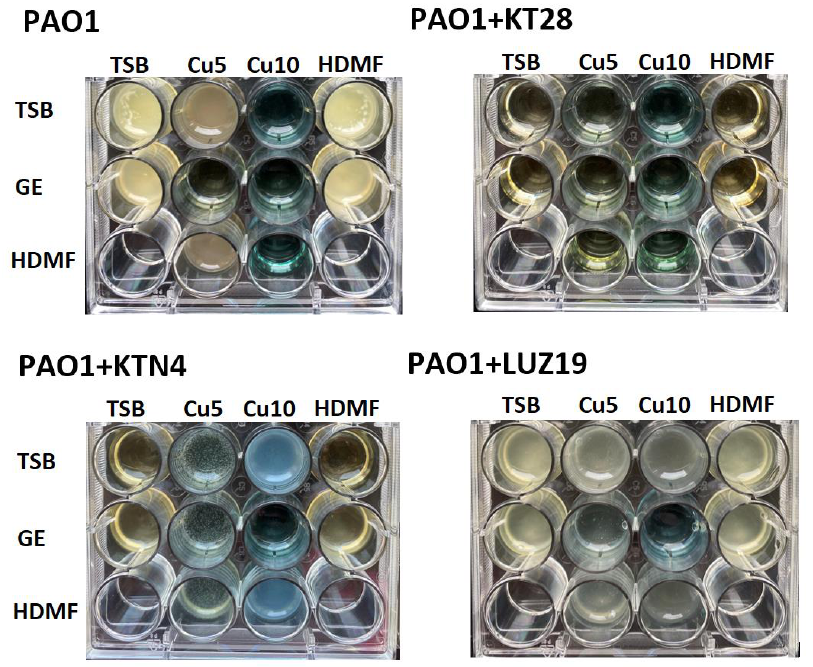
Figure 3. The impact of Cu 2+ , GE, and HDMF and their combination on the P. aeruginosa PAO1 culture growth when infected with ( a ) KT28, ( b ) KTN4, or ( c ) LUZ19 phages. The control consisted of untreated culture (orange solid curve). Fitted curves were established on the average of triplicate OD 600 measurement and the SD in the range +/ − 0 – 0.3. The kinetics were measured at 20 min intervals.